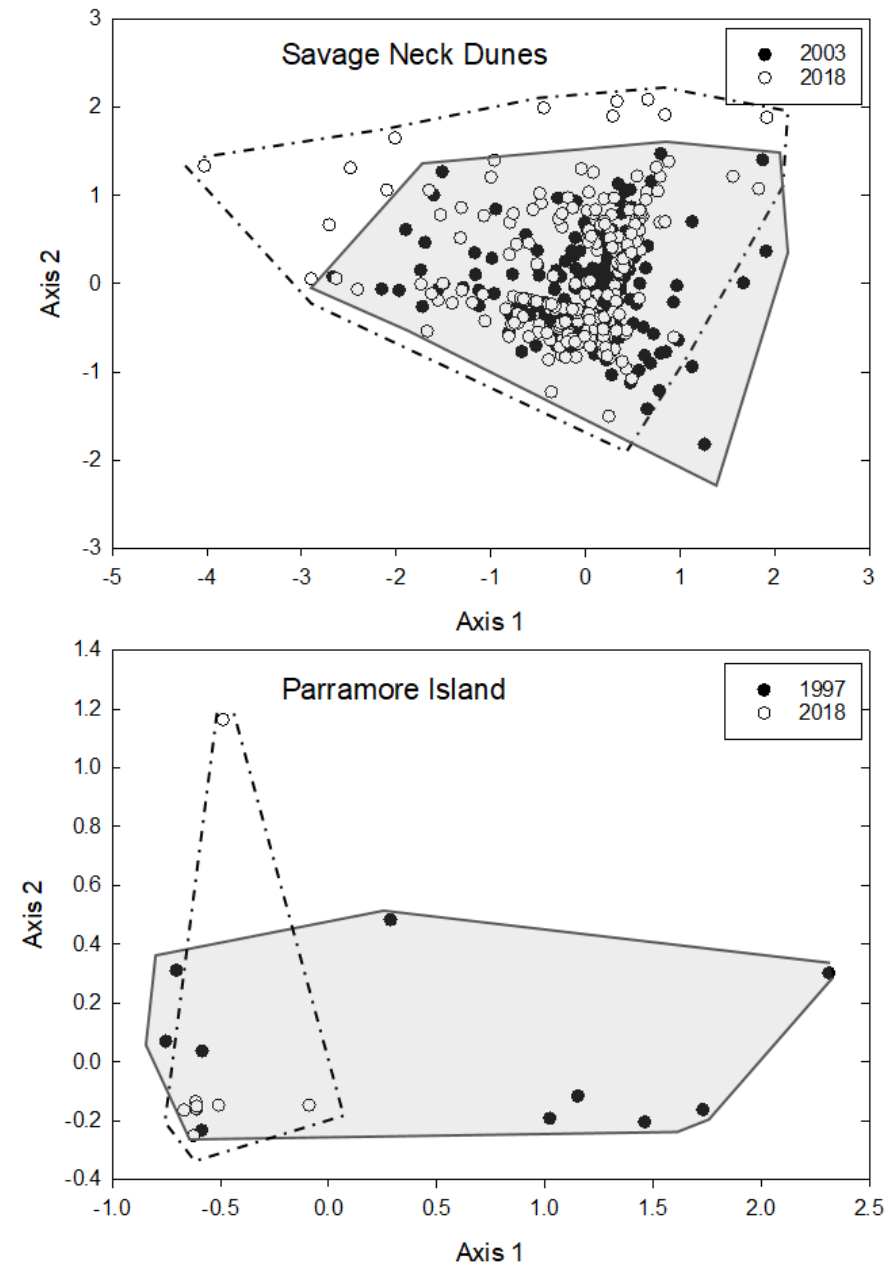
Figure 6. NMS of basal area at Savage Neck in 2003 and 2018, and Parramore Island in 1997 and 2018. Degree of overlap between the two years is highlighted with convex hulls (light gray = 2003 or 1997; dark gray = 2018).